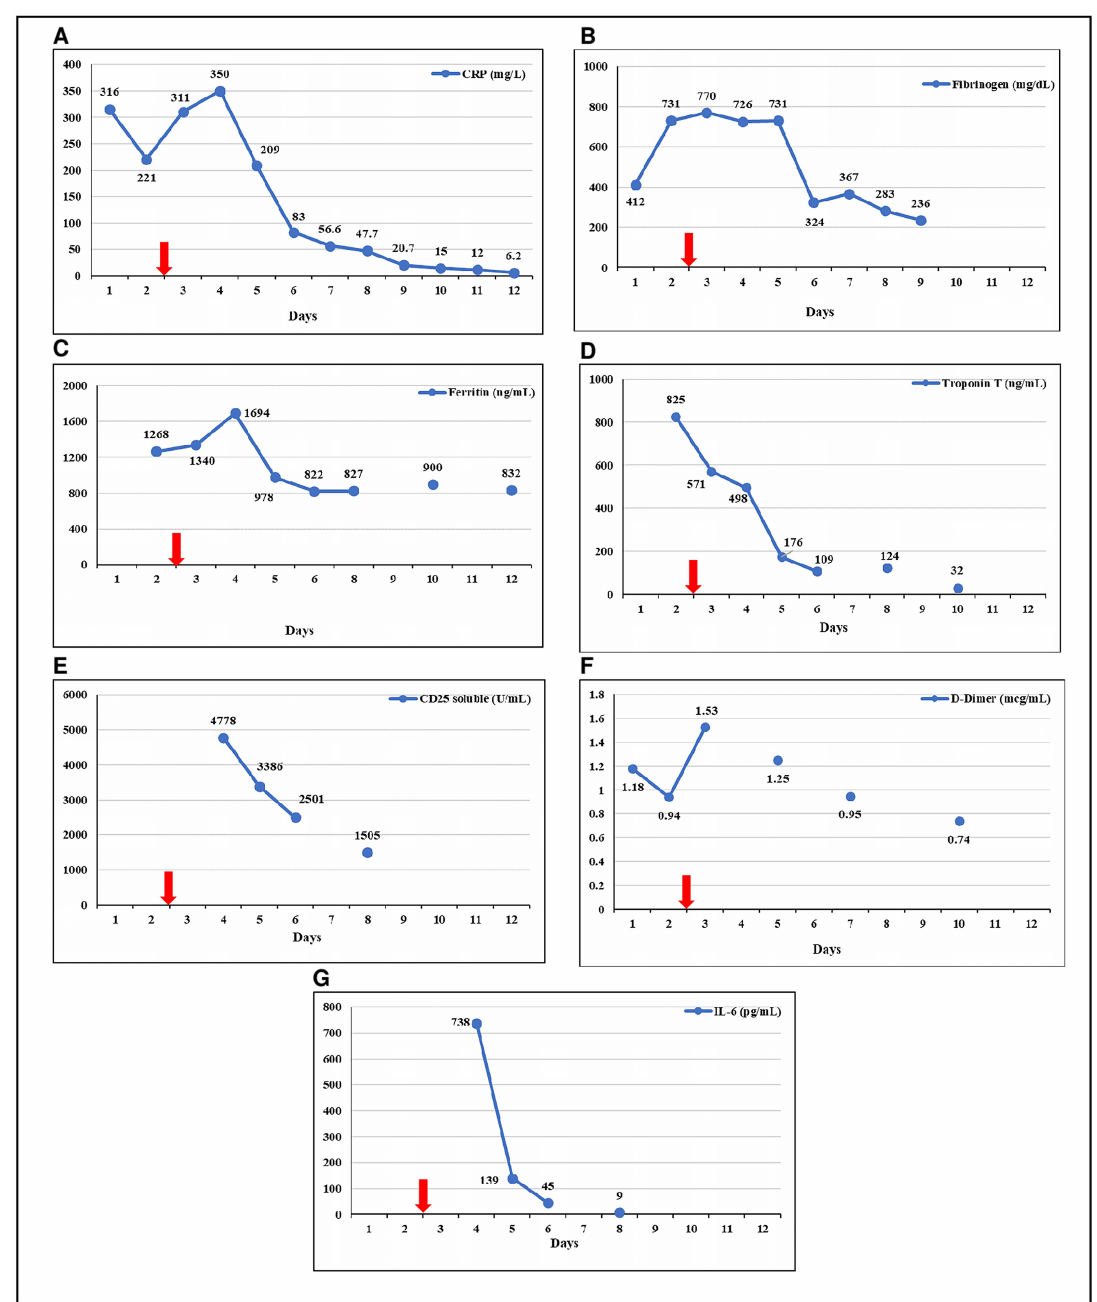
Figure 1. Evolution of inflammatory and cardiac parameters. ( A ) C reactive protein (CRP); ( B ) Fibrinogen; ( C ) Ferritin; ( D ) Troponin T; ( E ) CD25 soluble; ( F ) D-Dimer; ( G ) IL-6. Red arrow indicates the day of the administration of Tocilizumab. The last ferritin was taken on day 17 (200 ng /